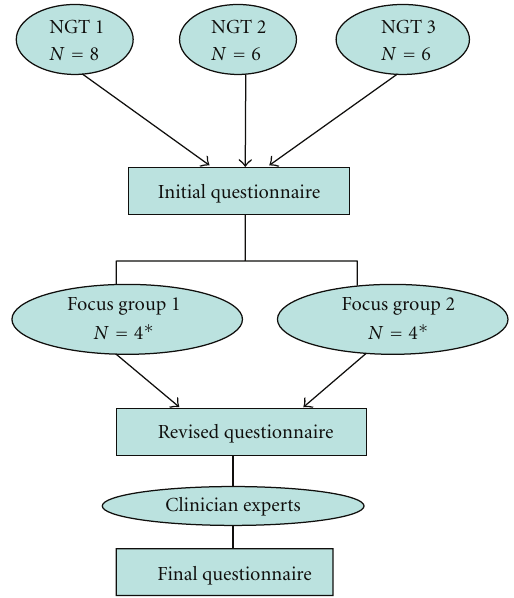
Figure 1: NMF questionnaire development schema. NGT: nominal group technique. ∗ Focus group consisted of both new subjects and original members of the NGT sessions.